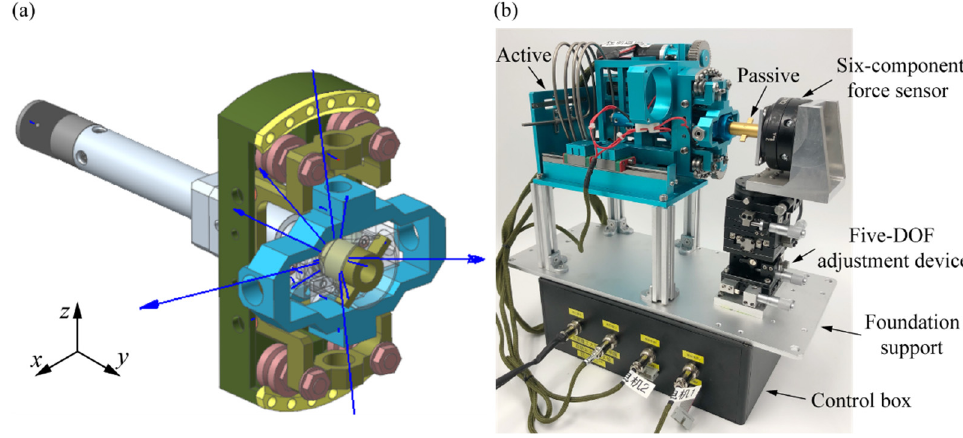
Figure 19. Components of the kinematic/dynamic ( a ) simulation system ( b ) experiment system.